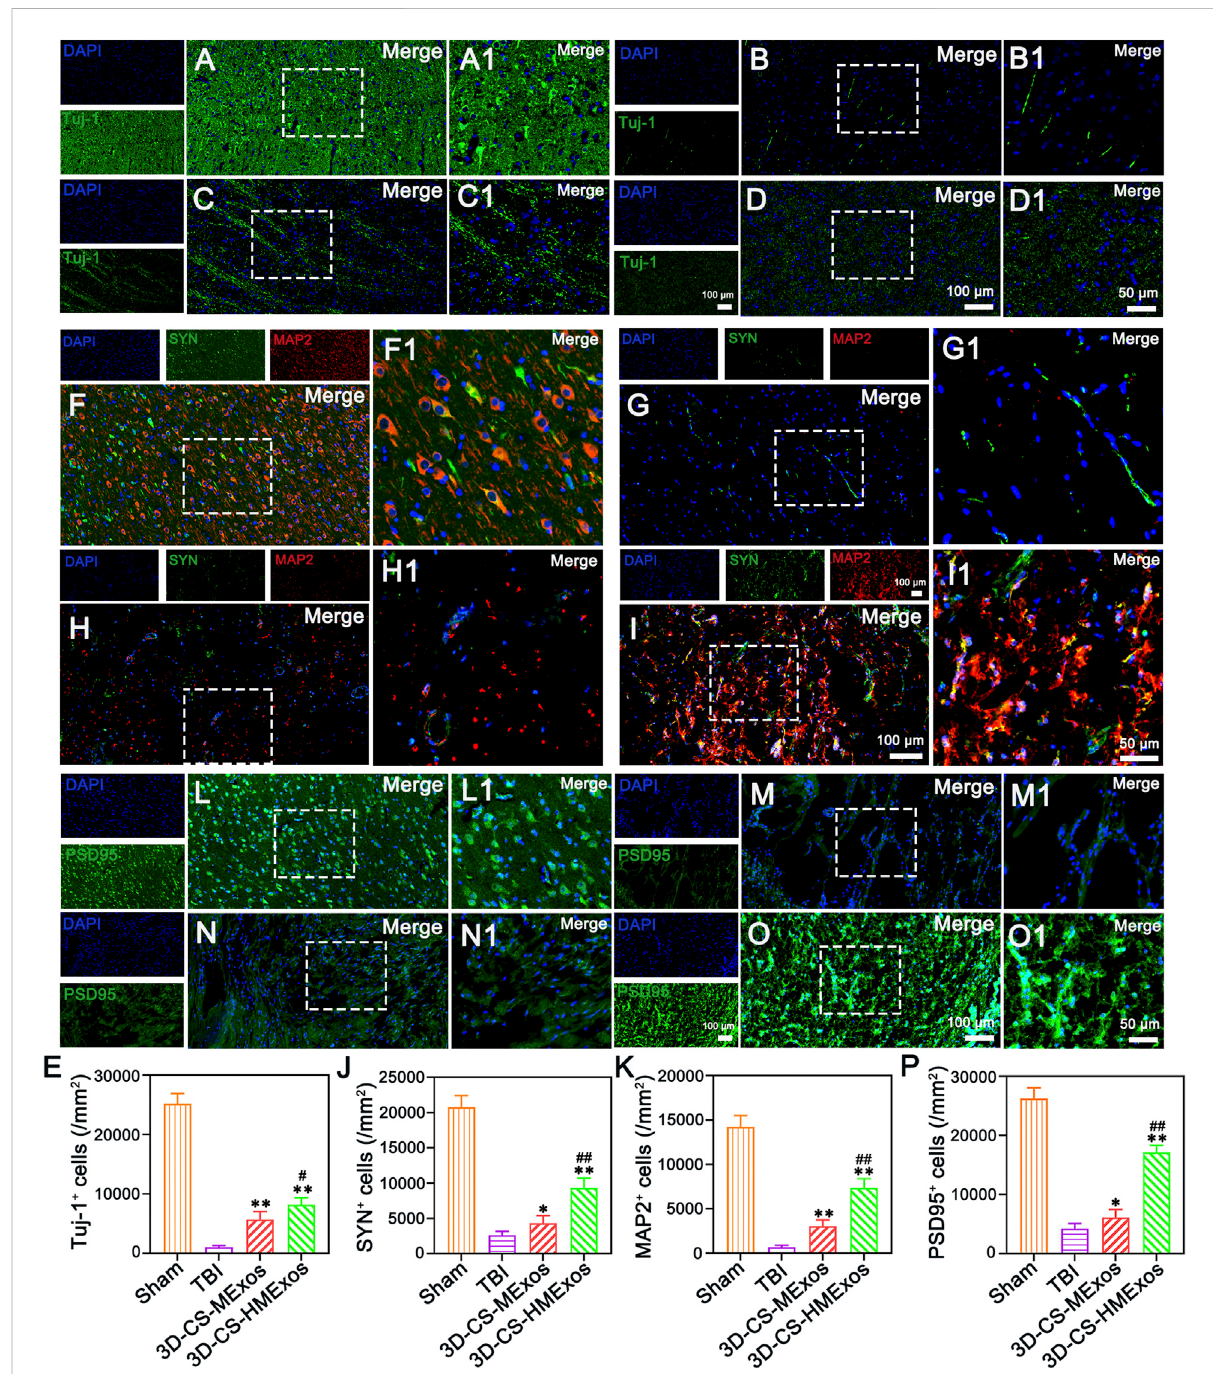
FIGURE 6 Regenerated neurons and synaptic connection formation at 6 months after TBI. (A – D) Representative images of Tuj-1-positive neurons in the lesion site of beagles in each group. (E) Quantitative analysis of Tuj-1 in injured brain tissues in the Sham, TBI, 3D-CS-MExos, and 3D-CS-HMExos groups. (F – I) Double-labelling of SYN and MAP2 immuno fl uorescence staining staining images of synapse formation at the lesion site, green: SYN; red:MAP-2. (J,K) SYN-andMAP-2-positivecellsinthefourgroupsat6 monthsaftertheoperation. (L – O) Representativeimmuno fl uorescence staining images showed another hallmark protein of synapses, PSD95, which serves as an important surface marker in neuronal excitatory postsynaptic membranes. (P) Quantitative analysis of PSD95-positive signals in the four groups, indicating that hypoxia-pretreated HUCMSCs- exosomes combined with 3D-printed collagen/ fi broin scaffolds could further promote the formation of synaptic connections after TBI. The image ontherightisanenlargedimageoftheimageinthewhiteboxoftheimageontheleft.* p < 0.05,** p < 0.01vs.TBIgroup. # p < 0.05, ## p < 0.01vs.3D- CS-MExos group, n =